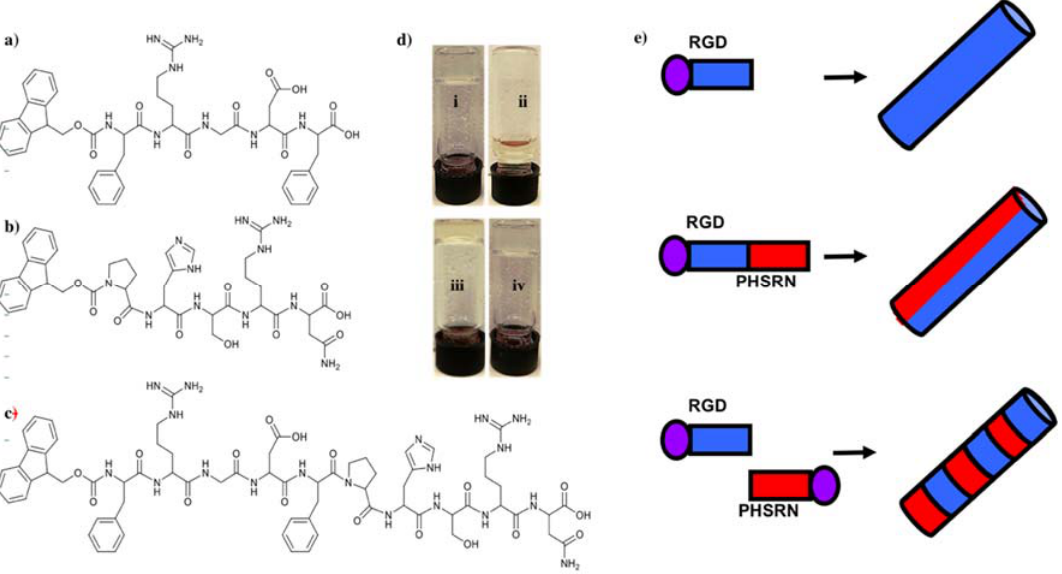
Figure 1. Molecular structure of three Fmoc-derived peptides. ( a ) Fmoc-FRGDF; ( b ) Fmoc-PHSRN; ( c ) Fmoc-FRGDFPHSRN and ( d ) hydrogels formed of (i) Fmoc-FRGDF; (ii) Fmoc-PHSRN; (iii) Fmoc-FRGDFPHSRN and (iv) peptide mixture of Fmoc-FRGDF/Fmoc-PHSRN (1:1, w / w ). ( e ) Cartoon schematic of the assembly process.